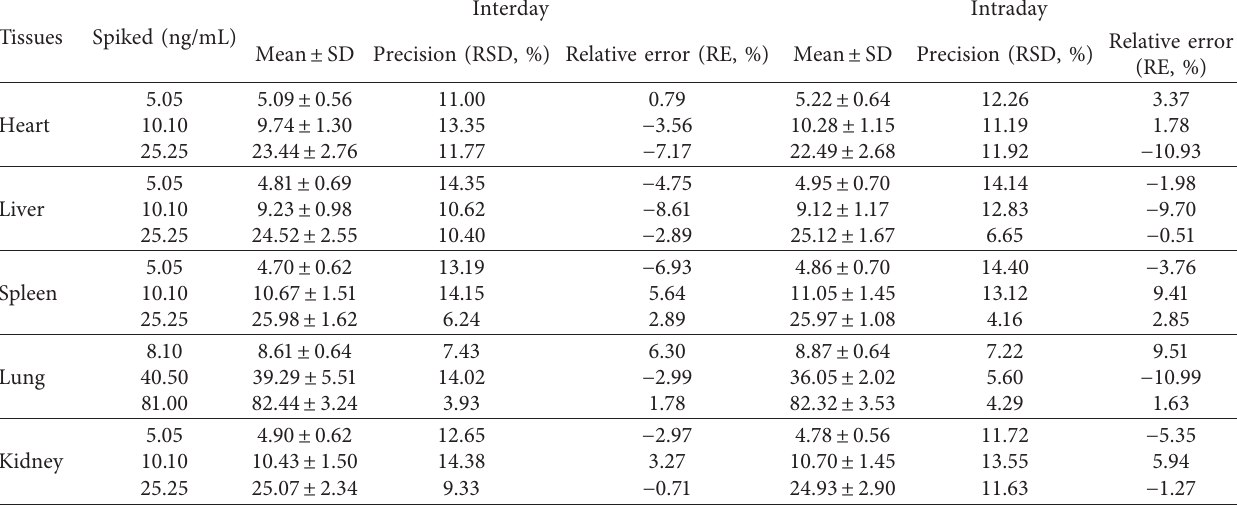
Table 4: Interday and intraday precision and accuracy data for assays of luteolin-7- O-β -D-glucoside in different tissues ( n � 6). Interday Intraday Tissues Spiked (ng/mL)